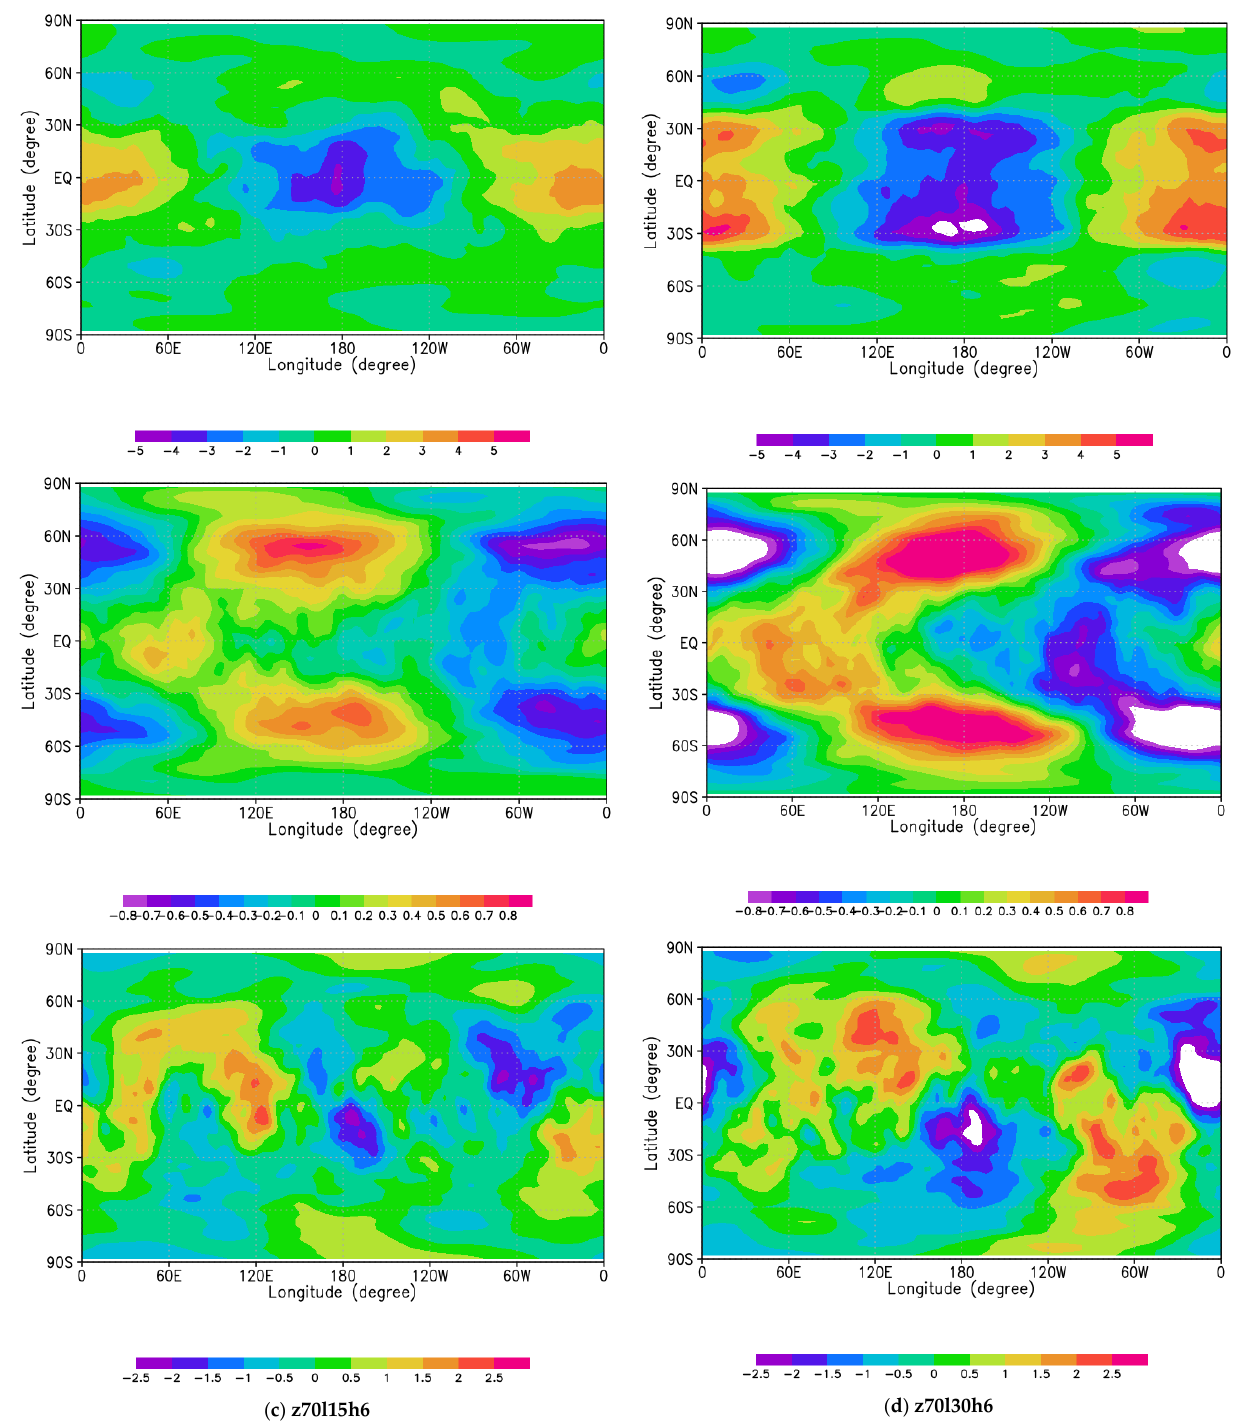
Figure 5. Composite means of zonal wind (top panels), temperature (middle panels), and meridional wind (bottom panels) in latitude-longitude cross sections at 70 km for ( a ) frf, namely, free run forecast of AFES-Venus, and the cases of ( b ) z70l5h6, ( c ) z70l15h6 and ( d ) z70l30h6 (analysis). The total number of visualized data used for composite means is 85, with every data arranged equally in purpose of extracting equatorial Kelvin-type waves with about 4-day